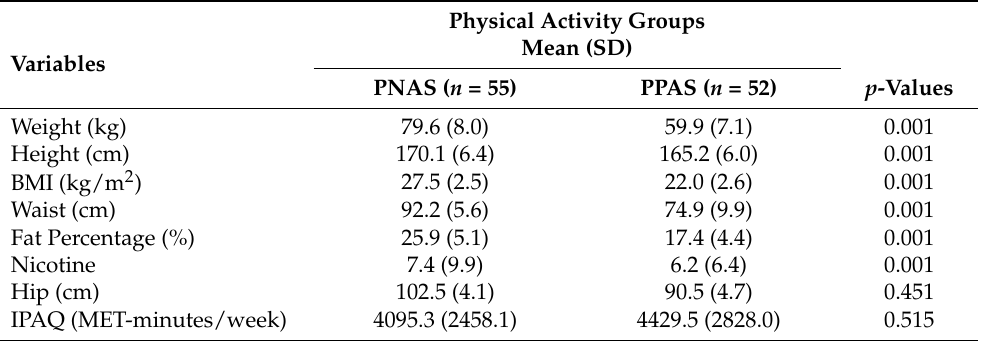
Table 3. The differences in the anthropometric and health variables between the physically non-active and the partially physically active smokers.